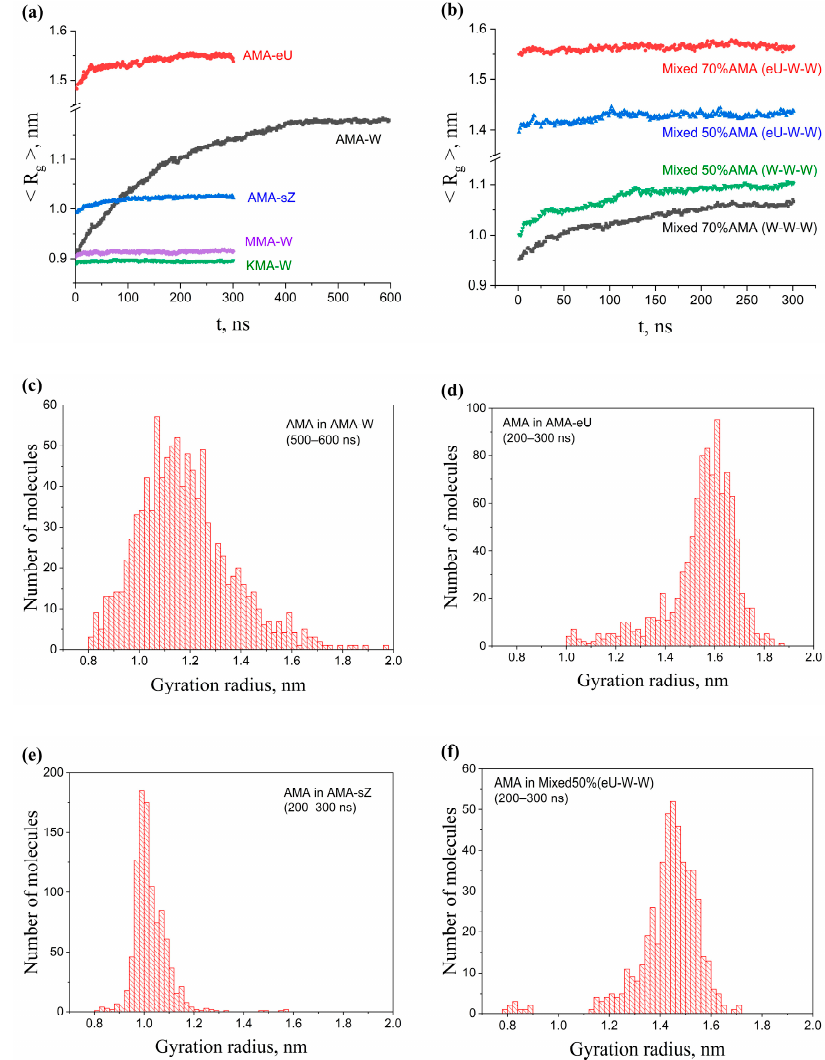
Figure 3. Time evolution of the average mass-weighted gyration radius of 1000 AMA molecules: ( a ) in the single-component membranes of different initial construction and composition (AMA-W, AMA-eU, AMA-sZ, KMA-W, and MMA-W); ( b ) in the multicomponent membranes of different initial construction and composition (140W–30W–30W, 140eU–30W–30W, and 100eU–50W–50W); ( c – f ) Distribution of R g for 1000 AMA molecules in membranes with different composition and structure at the time interval of 200–300 ns of NPT MD.